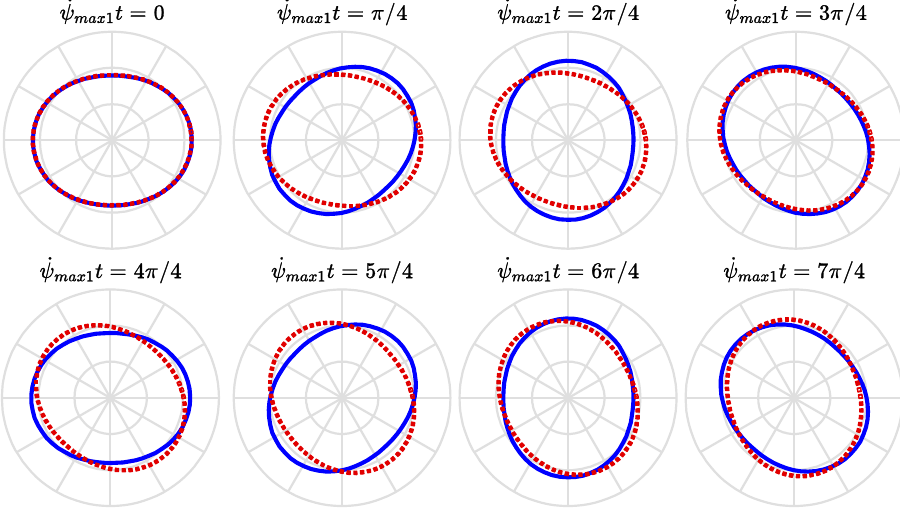
Figure 7. The traveling modes of n = 2 at various instance of time as viewed by a stationary observer.